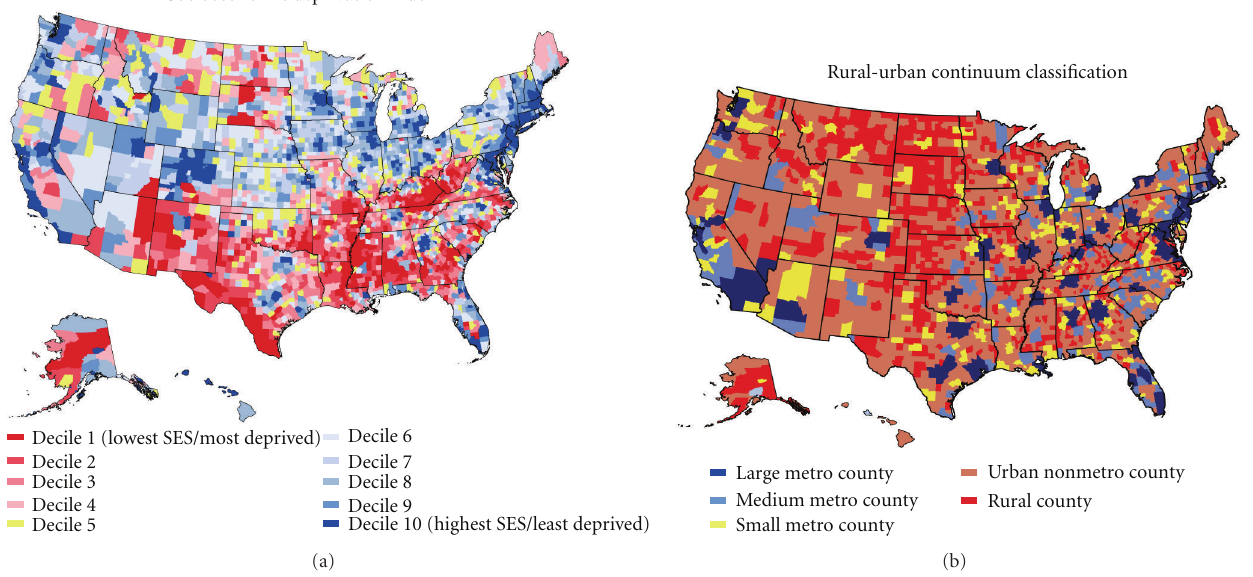
Figure 1: The 2000 county socioeconomic deprivation index and the 2003 rural-urban continuum classification for the United States (3,141